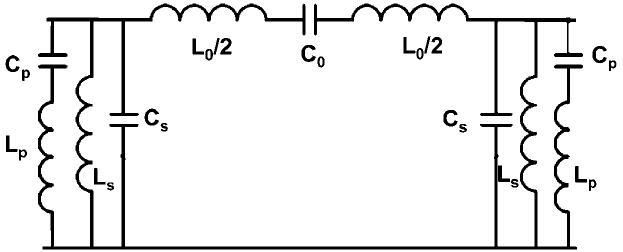
prototype.FIG. 10. E and H field magnitude of the PC1 mode showing weak influence of DT stems on PC mode pattern: PC field lines do not intersect DT stems.